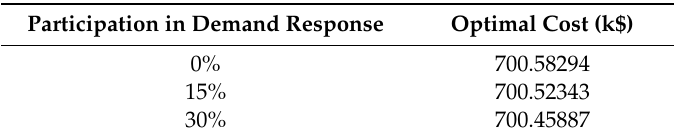
Table 16. The total cost of the system for different participation percent in demand response for a typical day in week 40.